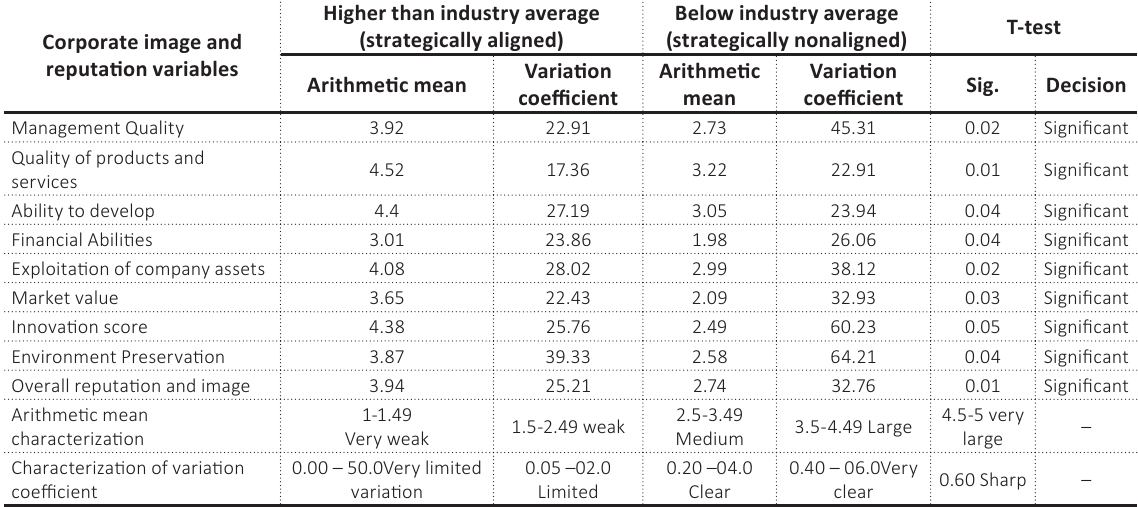
Table 4. Images and reputations of the companies surveyed from viewpoint of the research sample Corporate image and reputation